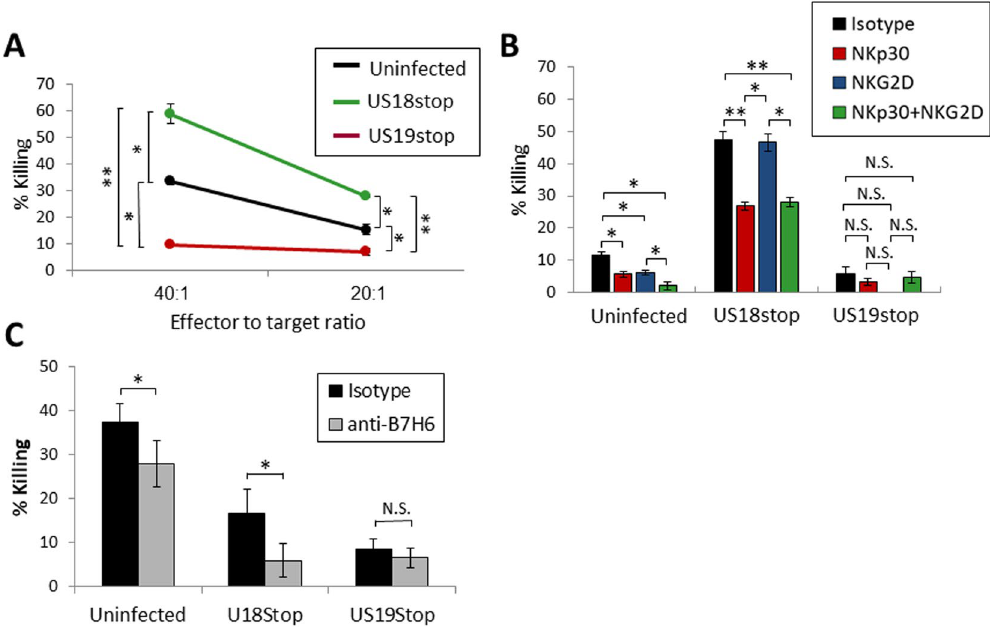
Figure 6. HCMV downregulation of B7-H6 leads to evasion from NKp30-mediated killing by NK cells. ( A ) NK cell killing of ARPE19 cells infected with different HCMV strains as depicted in the figure legend. Two effector to target ratios are presented as depicted on the X-axis. One representative experiment out of four is presented. ( B ) NK cell killing of ARPE19 cells infected with different HCMV strains and blocked using different antibodies as depicted in the figure legend. The isotype control antibody used was an anti-human CD99 antibody. Blocking experiments were performed at a 20:1 effector to target ratio. One representative experiment out of four is presented. ( C ) NK cell killing of ARPE19 cells infected with different HCMV strains and blocked with either isotype control antibody (black bars, polyclonal mouse IgG1) or anti-B7-H6 antibody (grey bars). One representative experiment out of two is presented. For all presented experiments error bars represent standard error of the mean. A student’s t test was performed in order to evaluate significance. * p-value < 0.05. ** p-value < 0.005. N.S. = non-significant